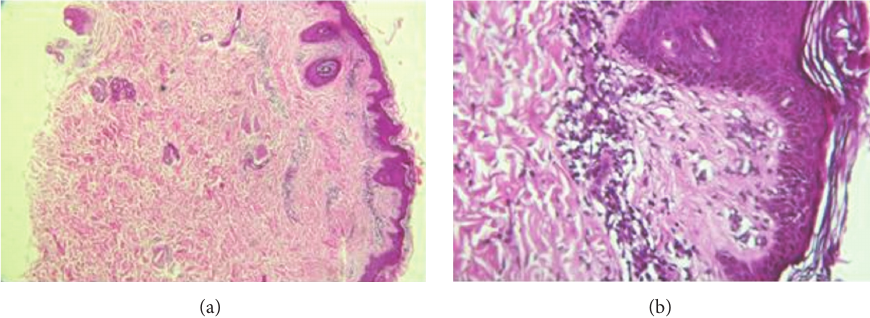
Figure 2: Lymphocytic vasculitis: histopathological examination shows predominantly lymphocytic infiltrate surrounding the walls of small vessels in the dermis accompanied by plumping of endothelial cells ((a), × 40, and (b), × 400, H-E stain).